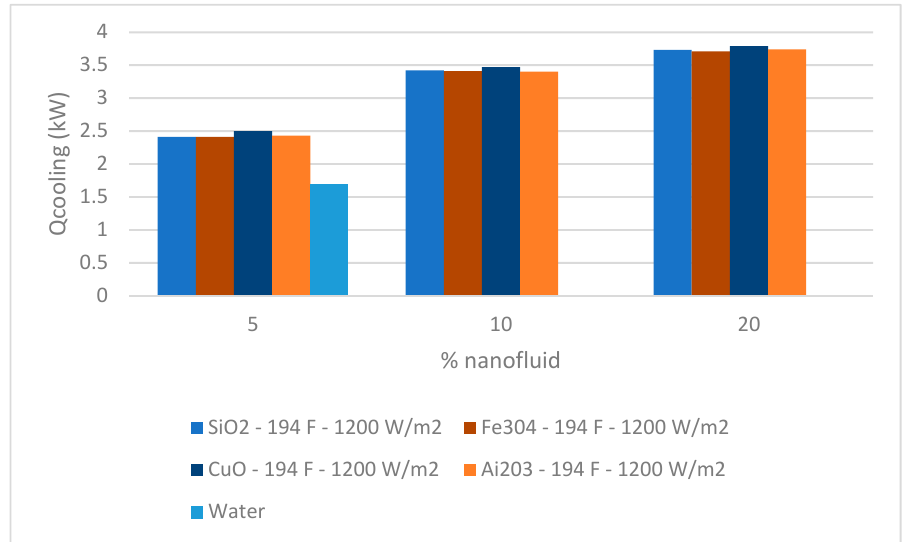
Figure 20. Hybrid system cooling e ff ect for di ff erent